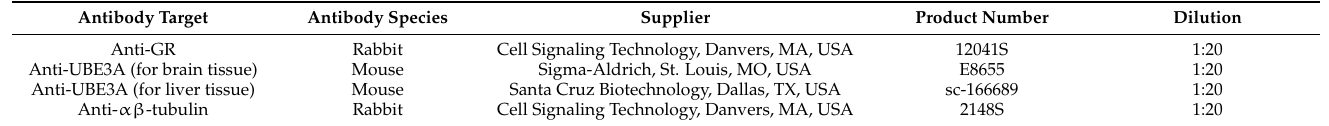
Table 2. List of primary antibodies used to assess GR and UBE3A protein levels in animal